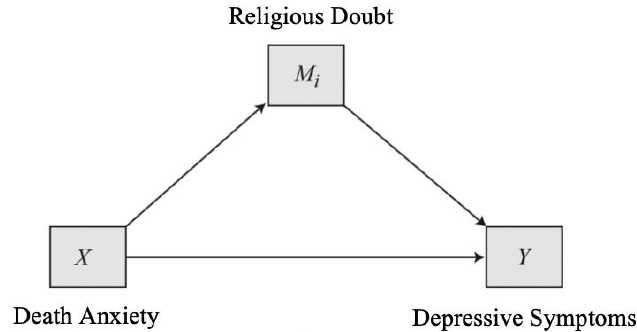
Figure 1. Conceptual diagram of the mediation analyses.